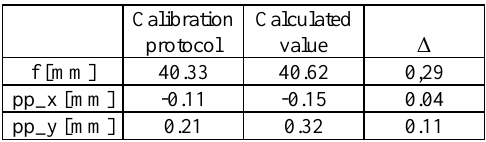
Table 3. Results of camera calibration for 40 mm lens.